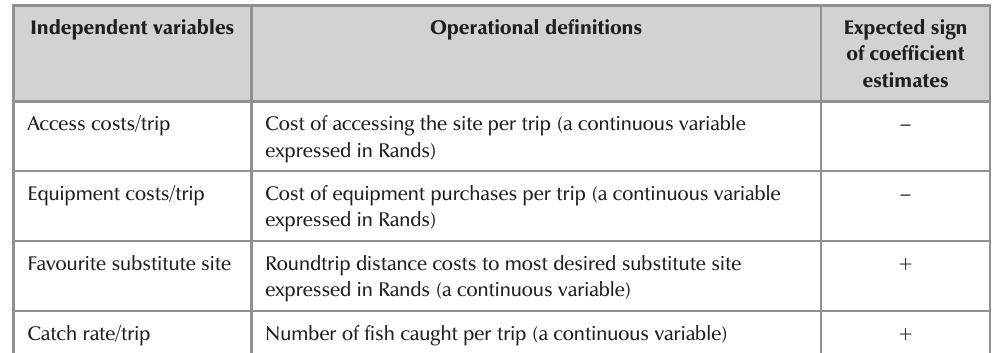
Tobit model independent